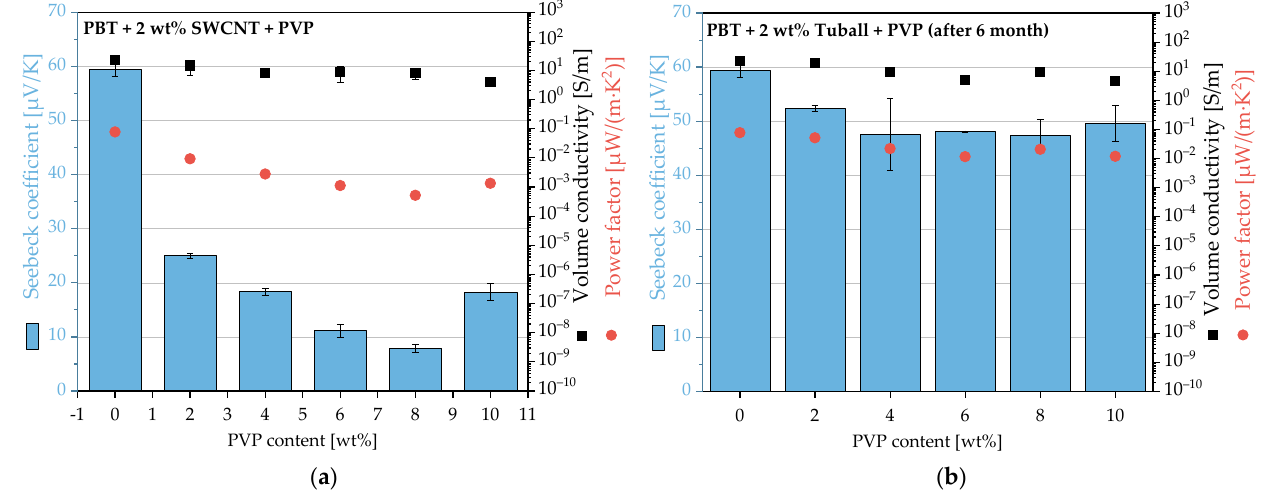
Figure 5. TE properties of PBT composites with 2 wt% SWCNT Tuball and different contents of PVP, first measurements ( a ), and measurement repeated after 6 months ( b ).